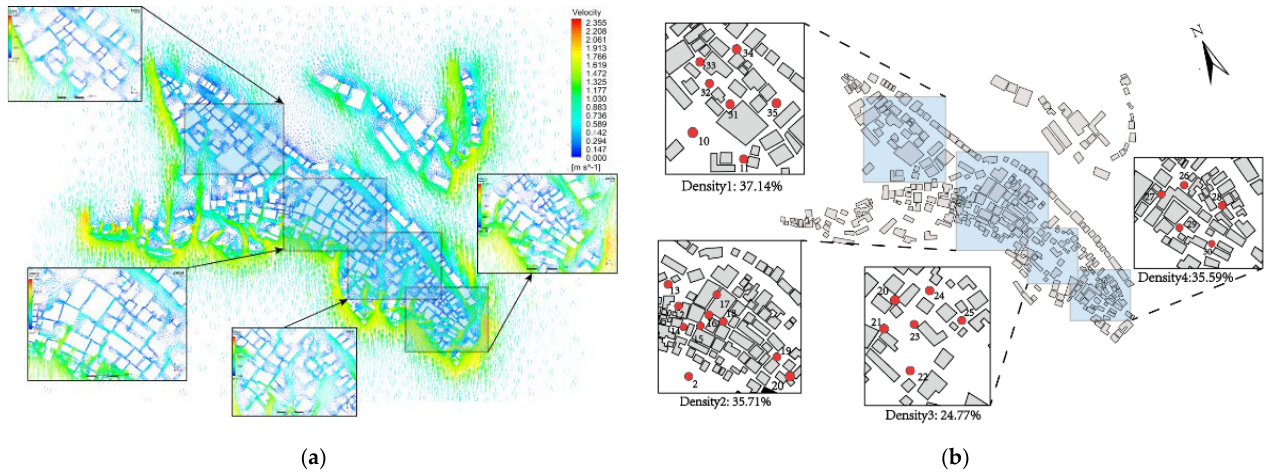
Figure 5. ( a ) Wind environment of study case. ( b ) Study cases are divided by different building densities.